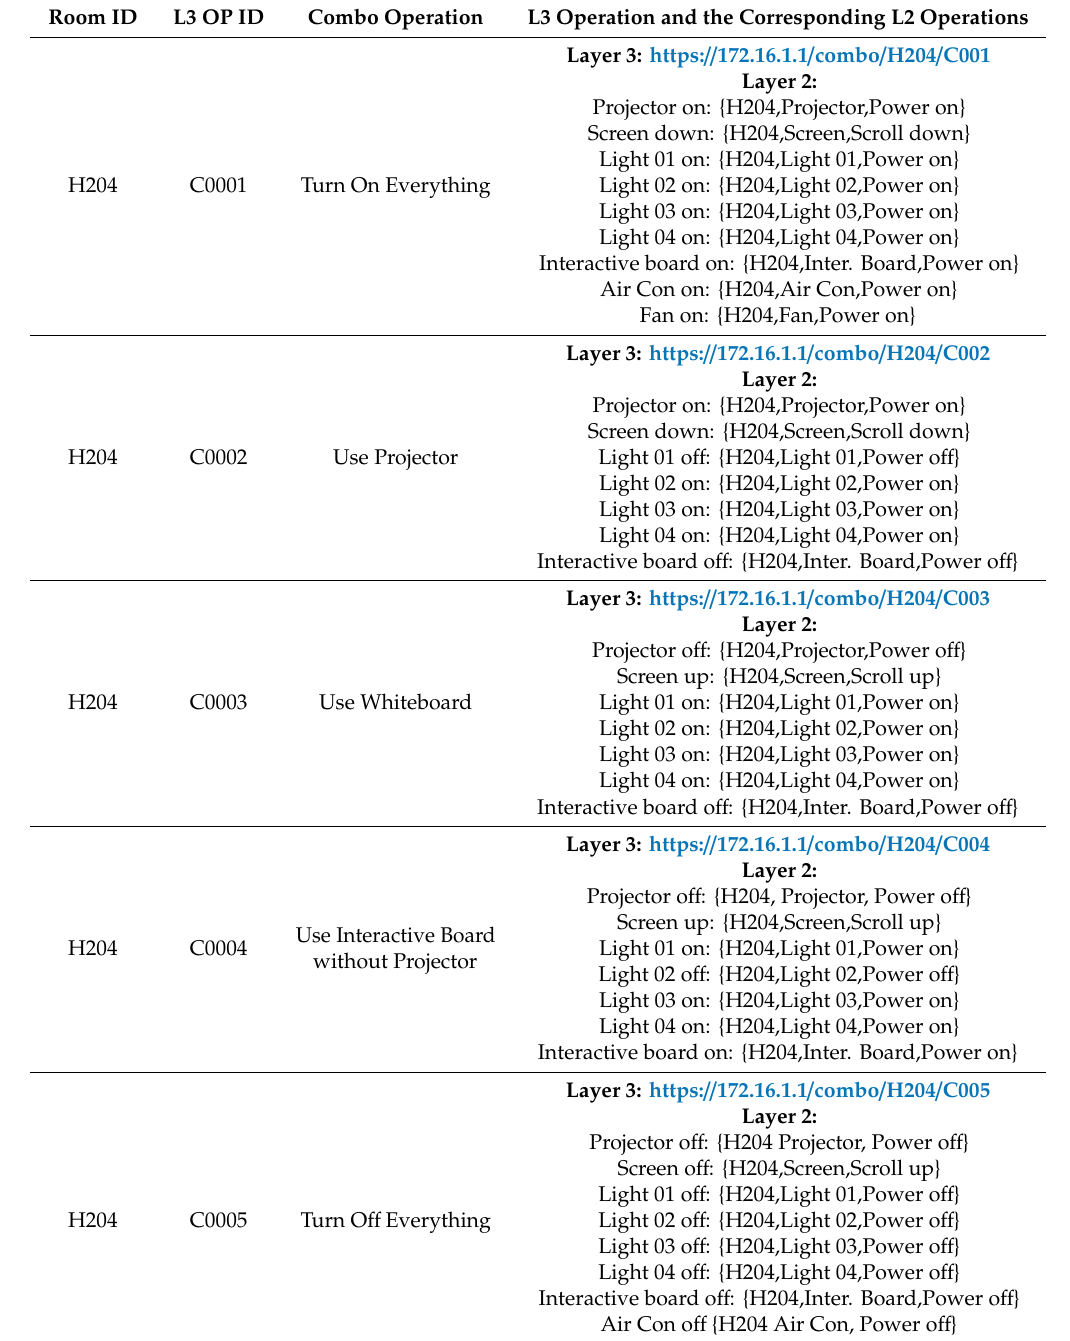
Table A5. Layer 3 Combo operations configured on the central web